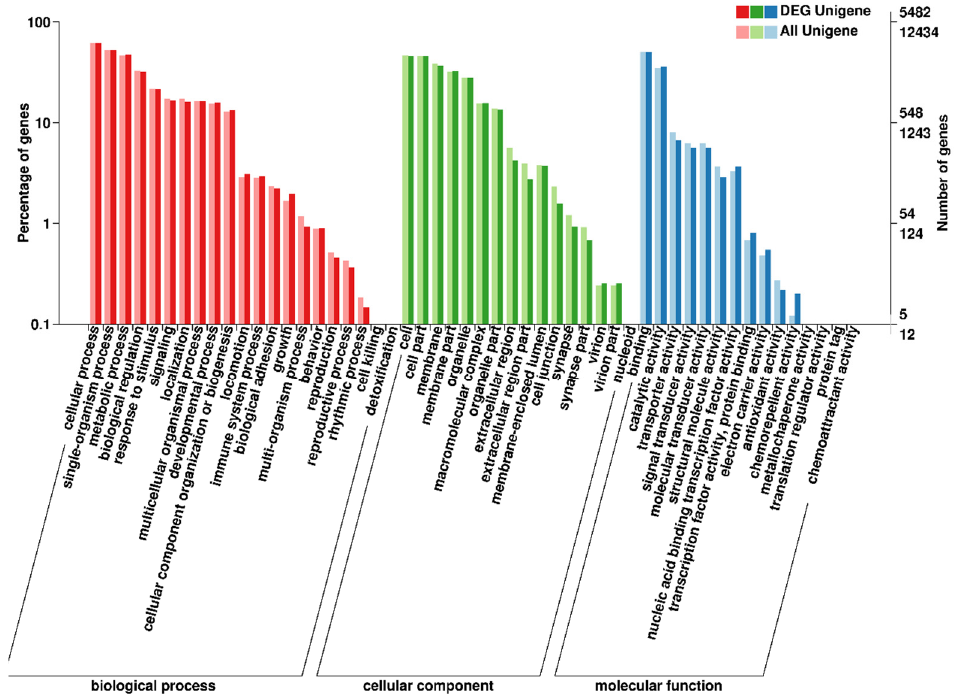
Figure 3. Functional annotation of DEGs based on GO categorization. The horizontal axis indicates the GO functions, and the vertical axis represents the number of genes with GO function.